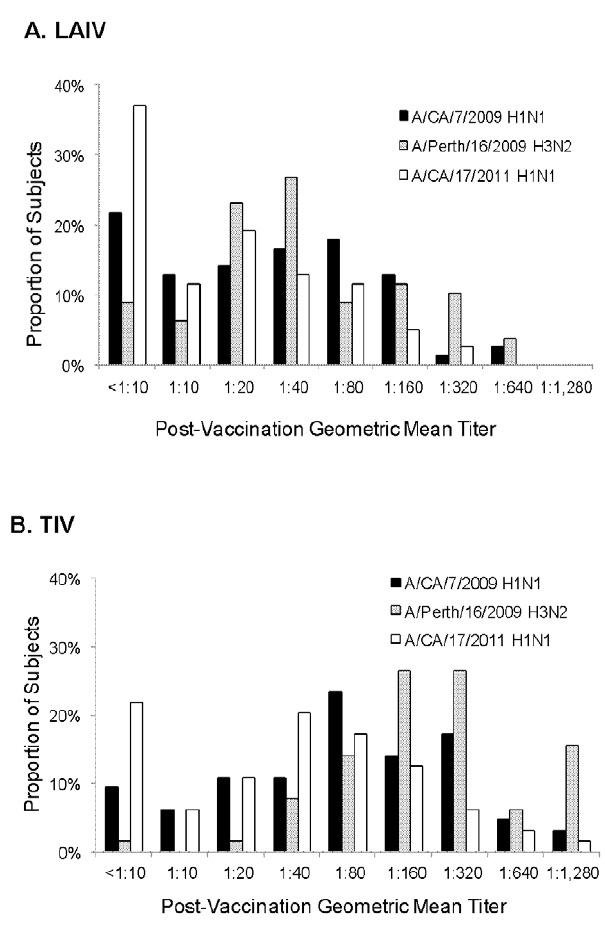
Figure 1. Post-vaccination microneutralization titer distribu- tion responses in vaccinated recruits based upon vaccine type.